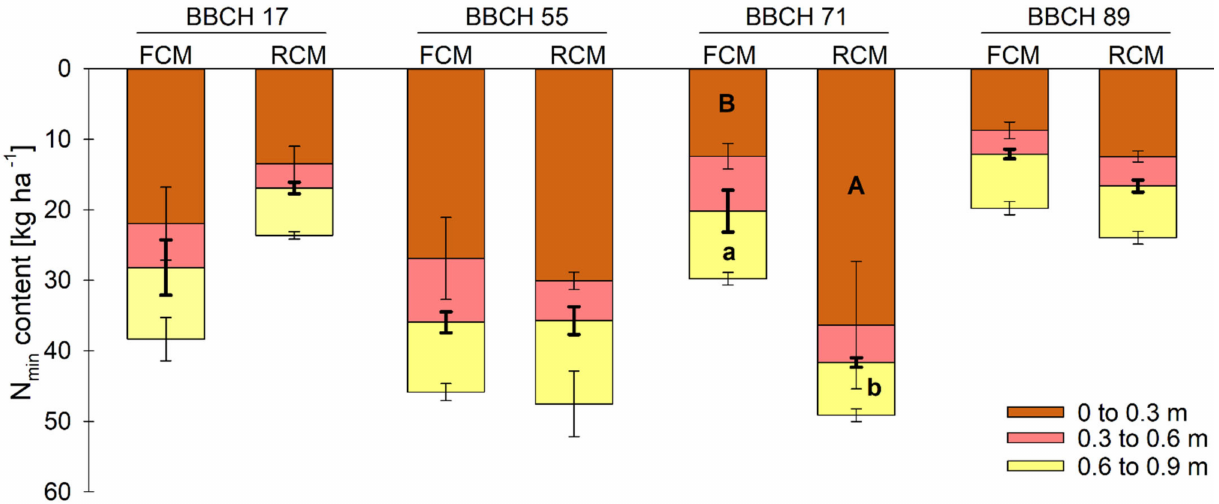
Figure 2. Soil N min content [kg ha − 1 ] in FCM and RCM during En BR20 for BBCH stages 17 (7 leaves unfolded), 55 (middle of tassel emergence: tassel begins to separate), 71 (beginning of grain development, about 16% dry matter) and 89 (fully ripe). Arithmetic means ± standard error for the respective soil depth and BBCH stage. Tukey–Kramer, significance at p < 0.05. Different letters indicate significance among the respective soil depth and BBCH stage. BBCH 17: 0 to 0.3 m p = 0.15; 0.3 to 0.6 m p = 0.50; 0.6 to 0.9 m p = 0.34. BBCH stage 55: 0 to 0.3 m p = 0.61; 0.3 to 0.6 m p = 0.38; 0.6 to 0.9 m p = 0.74. BBCH 71: 0 to 0.3 m p = 0.04; 0.3 to 0.6 m p = 0.54; 0.6 to 0.9 m p = 0.01. BBCH stage 89: 0 to 0.3 m p = 0.11; 0.3 to 0.6 m p = 0.22; 0.6 to 0.9 m p =